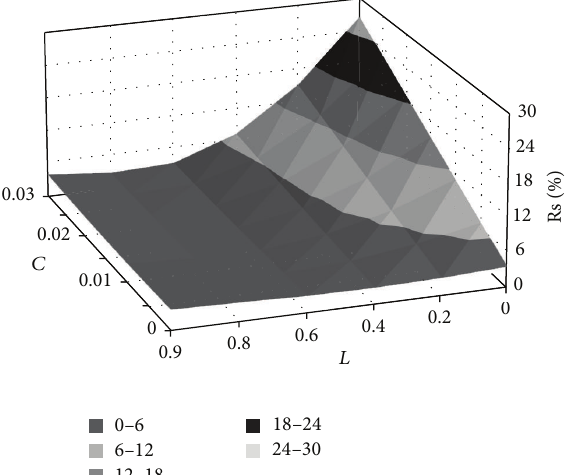
Figure 6: Xerogels bulk density in function of their composition.